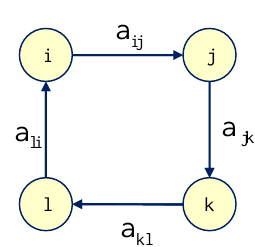
Figure 1. Cycle of length 4.